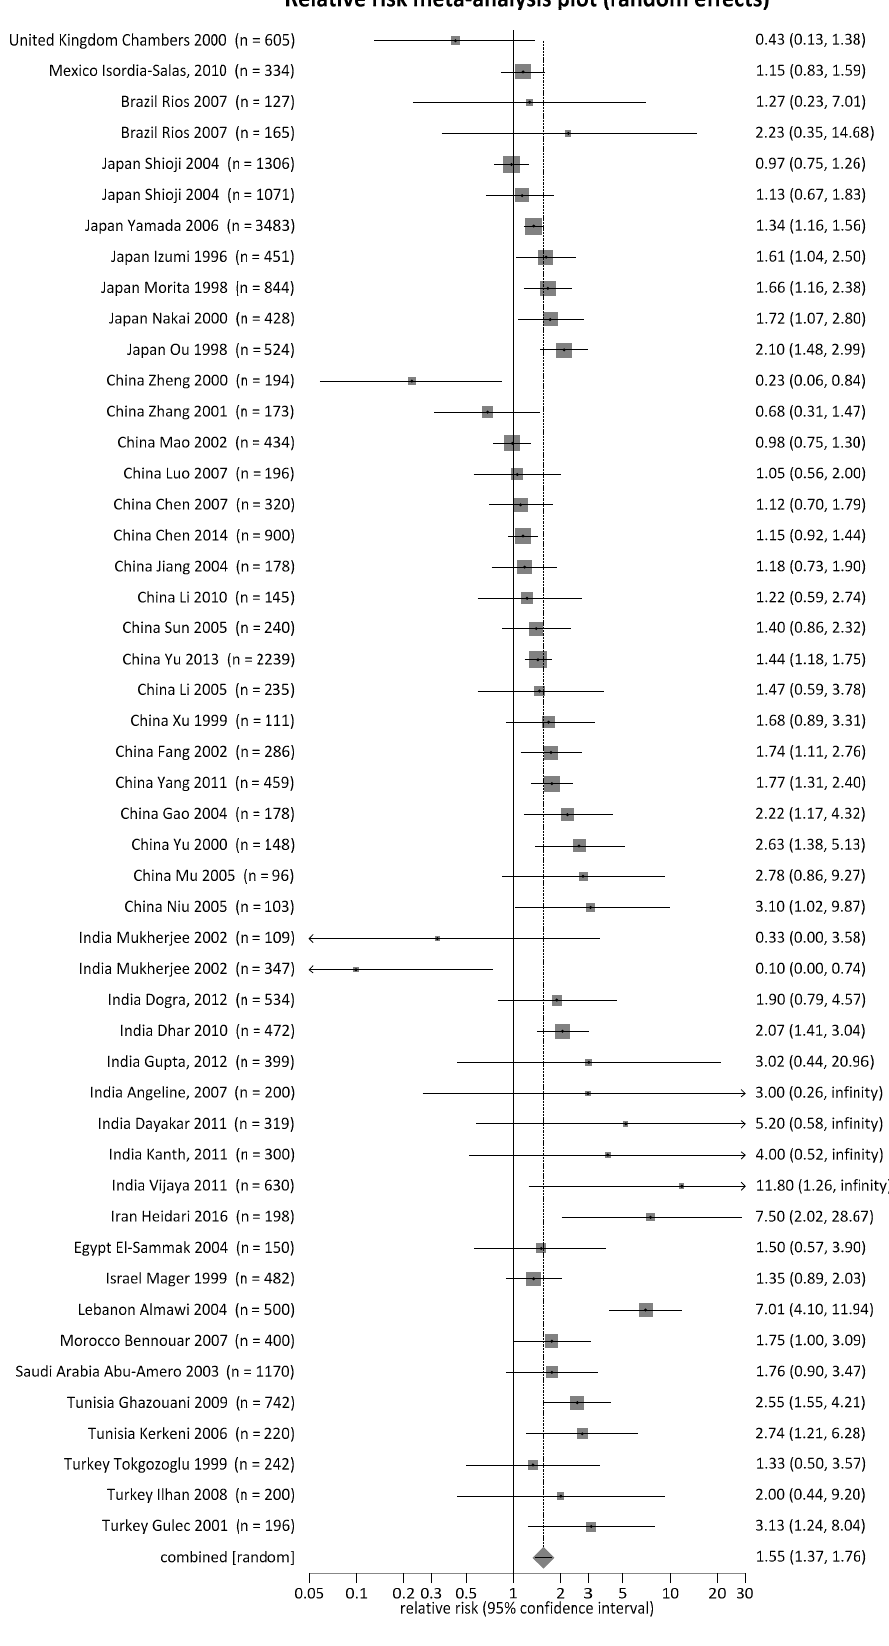
Figure 2. Forest plot for the meta-analysis of MTHFR 677 polymorphism by TT genotype, countries of non-Caucasian ethnicity with risks >1.